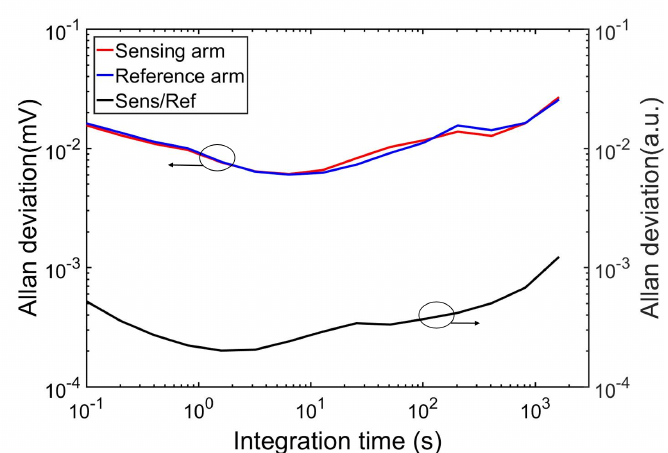
Figure 7. Allan deviation plot of the sensing and reference arm, as well as the normalized signal (in pure N 2